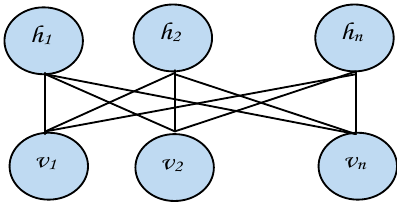
Figure 2. Restricted Boltzmann machine.